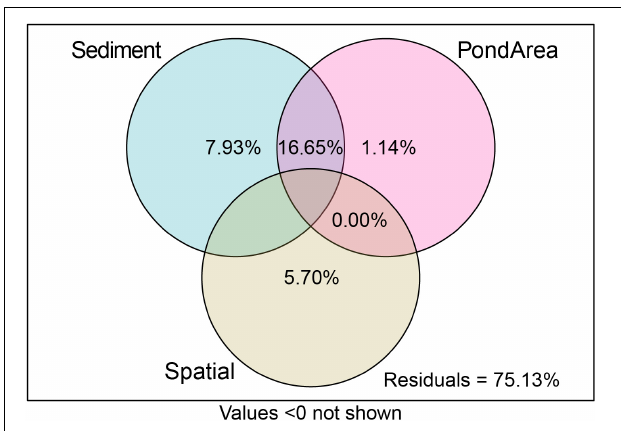
FIGURE 8 | The results of variation partitioning analysis (VPA) of the distribution of trait